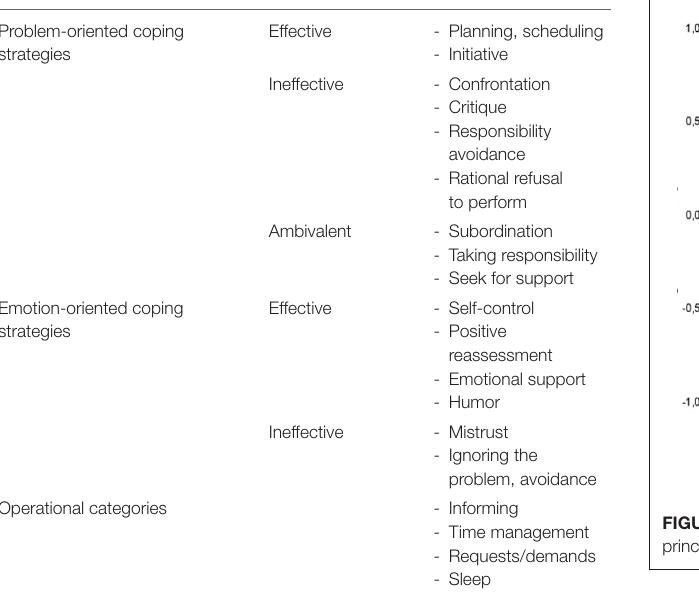
TABLE 1 | Content analysis categories used in study.